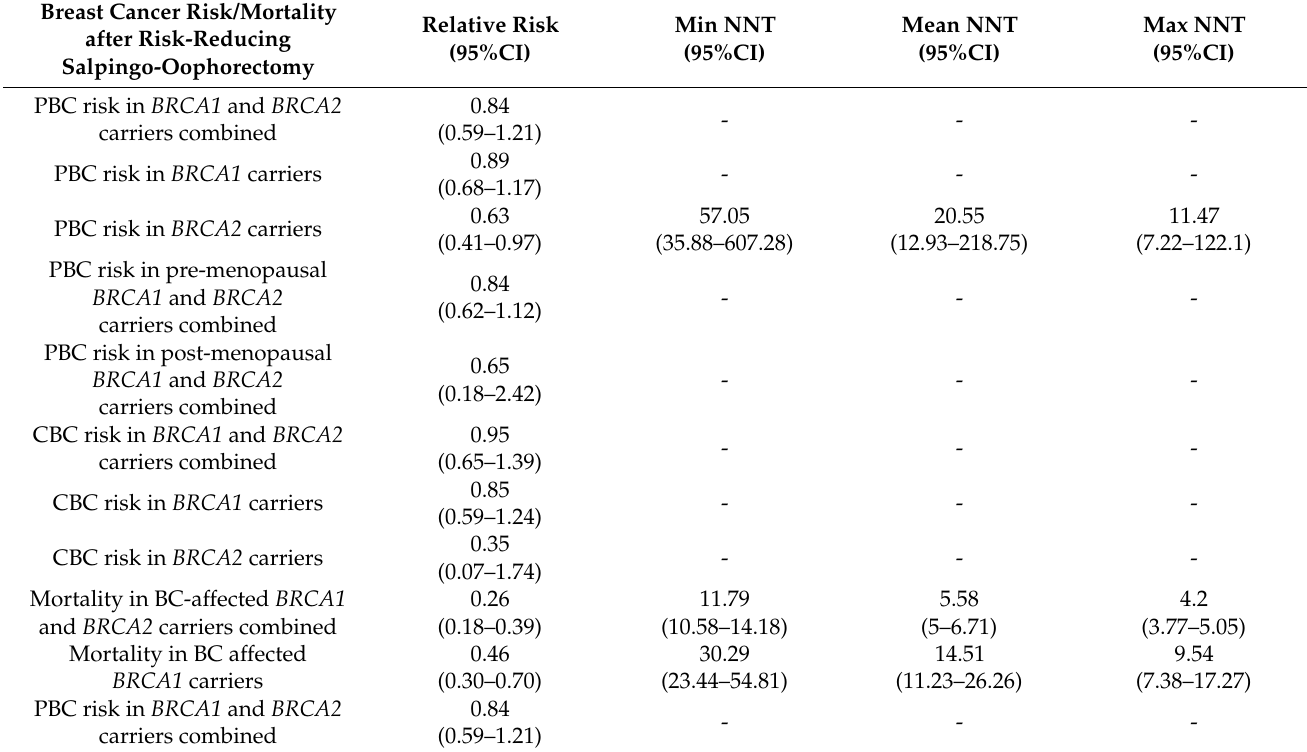
Table 4. Summary of pooled relative risks, confidence intervals and numbers needed to